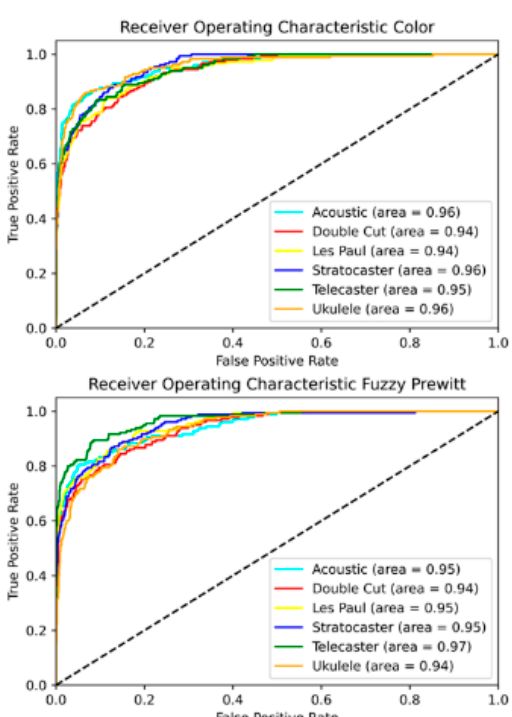
Figure 10. ROC curve for CNN-I.